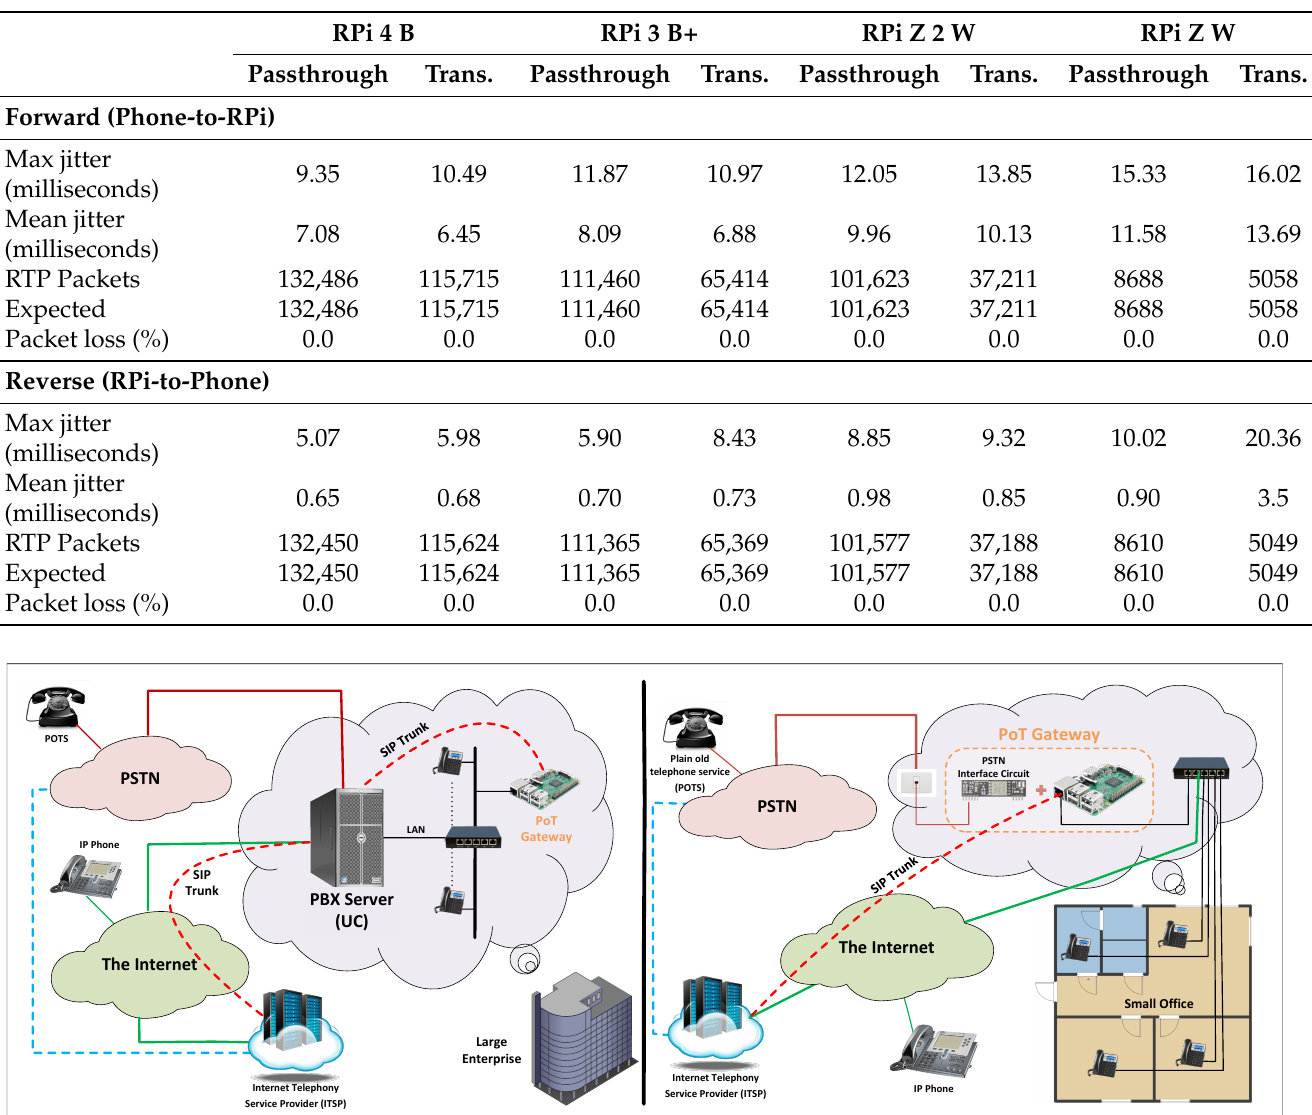
Table 2. VoIP call quality measurements during passthrough and transcoded VoIP call testings for different Raspberry Pi boards.